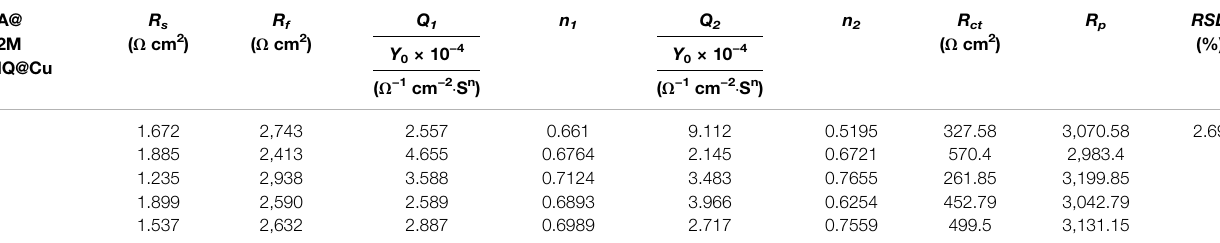
TABLE 5 | Reproducibility of anticorrosion performance obtained from EIS measurements recorded with the self-healing tests on fi ve different PDA@0.02M 8-HQ